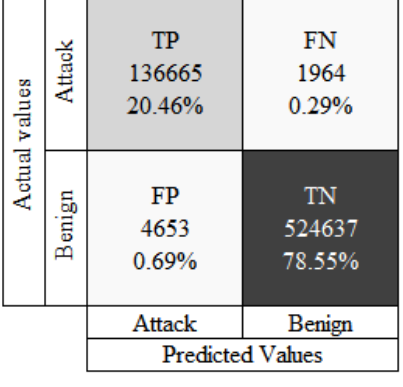
Figure 4. Confusion matrix with our results.